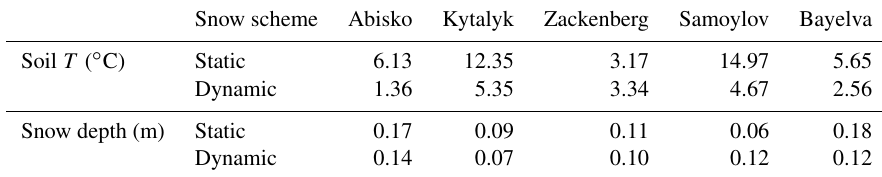
Table 1. RMSE for soil temperature and snow depth for the applied snow schemes for the single site simulations. Snow scheme